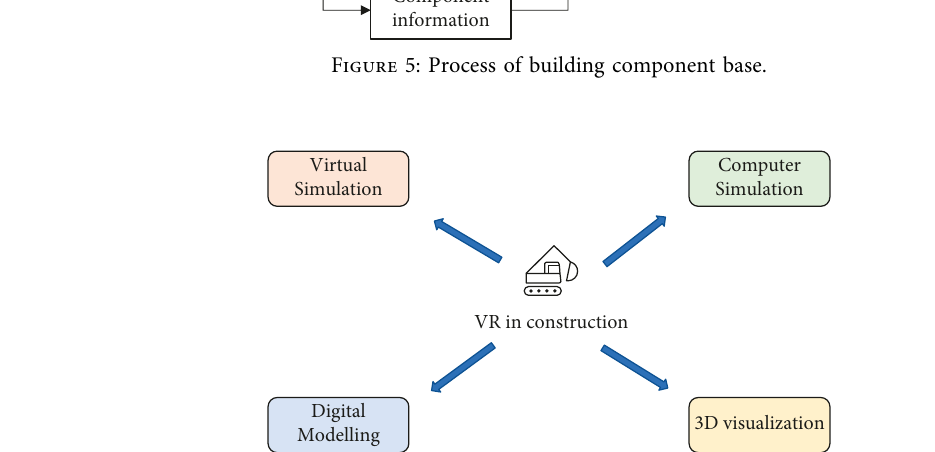
Figure 6: Main application of VR technology.